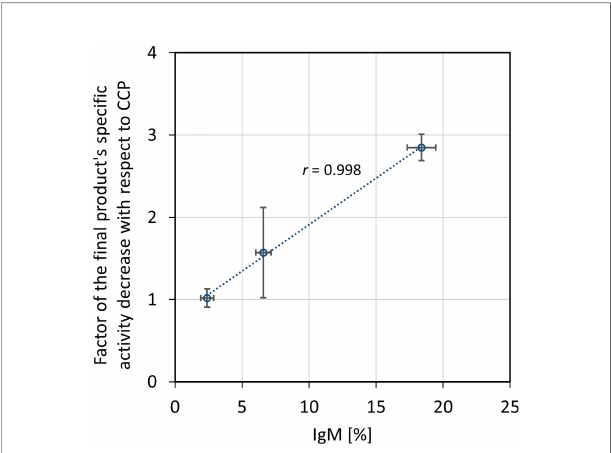
FIGURE 4 | Relationship between factor of the fi nal product ’ s speci fi c activity decrease in comparison to the COVID-19 convalescent plasma (CCP) and IgM share in the immunoglobulin pool of the starting material. Correlation was assessed by Pearson ’ s correlation coef fi cient ( r ) using a signi fi cance level of 5%. Speci fi c activity was expressed as neutralization potency, determined by the wild-type SARS-CoV-2 ED 50 assay, per mg of IgG. The results are given as (geo)mean from eight independently performed re fi nement procedures ± standard deviation (denoted by error